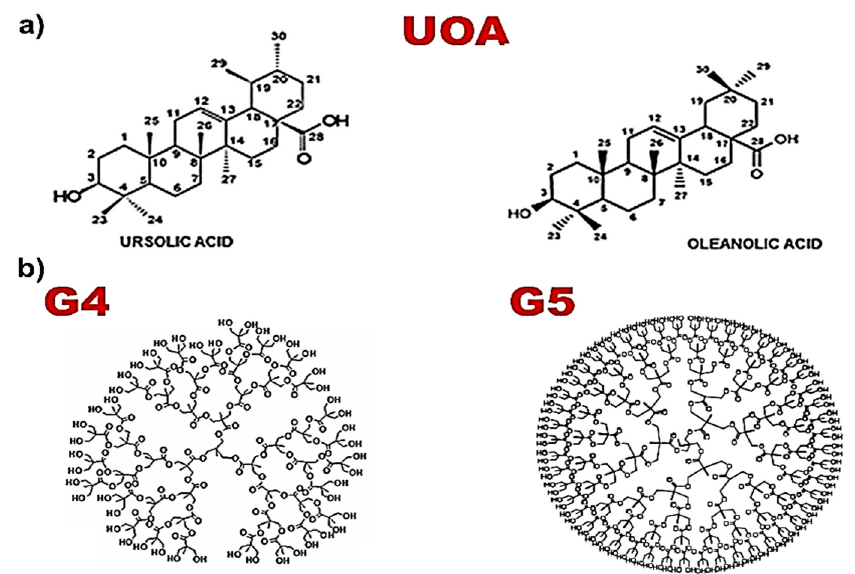
Figure 1. Structure of commercially available ursolic acid (UA) and oleanolic acid (OA), loaded as 1:1 mixture into the cationic dendrimers (CDs) ( a ); structure of the uncharged fourth (G4)- and fifth (G5)-generation polyester-based inner scaffolds of the three CDs ( b ).